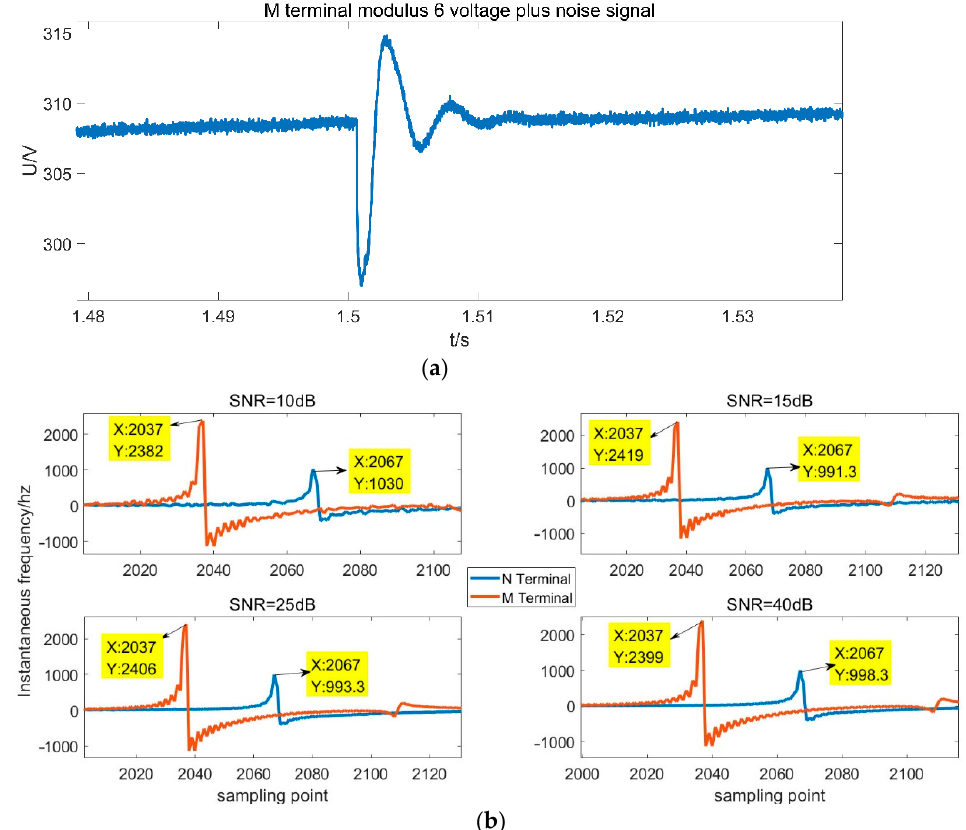
Figure 12. Analysis of noisy signals. ( a ) Voltage traveling wave signal plus noise waveform. ( b ) Instantaneous frequency at different signal-to-noise ratios Table 3. Algorithm ranging accuracy verification under different proportions of noise. Fault Distance (km)